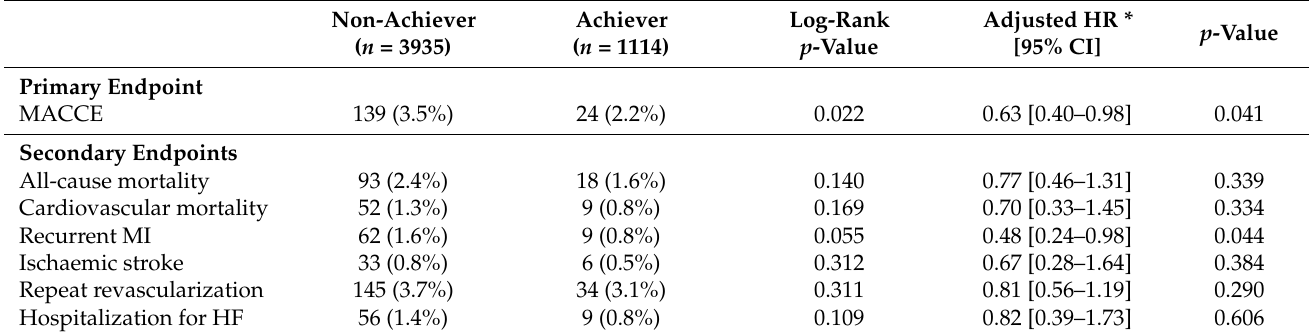
Table 3. Incidence and risk of primary and secondary endpoints.